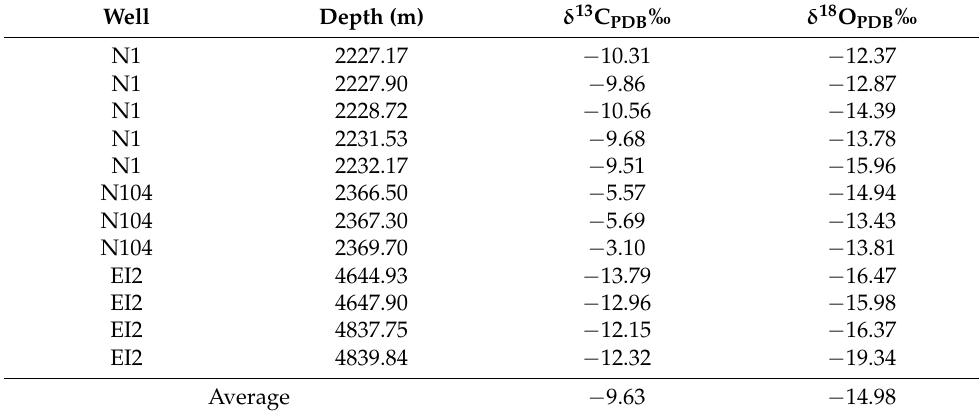
Table 2. Carbon and oxygen isotope data of carbonate cements of the Lower Jurassic reservoir